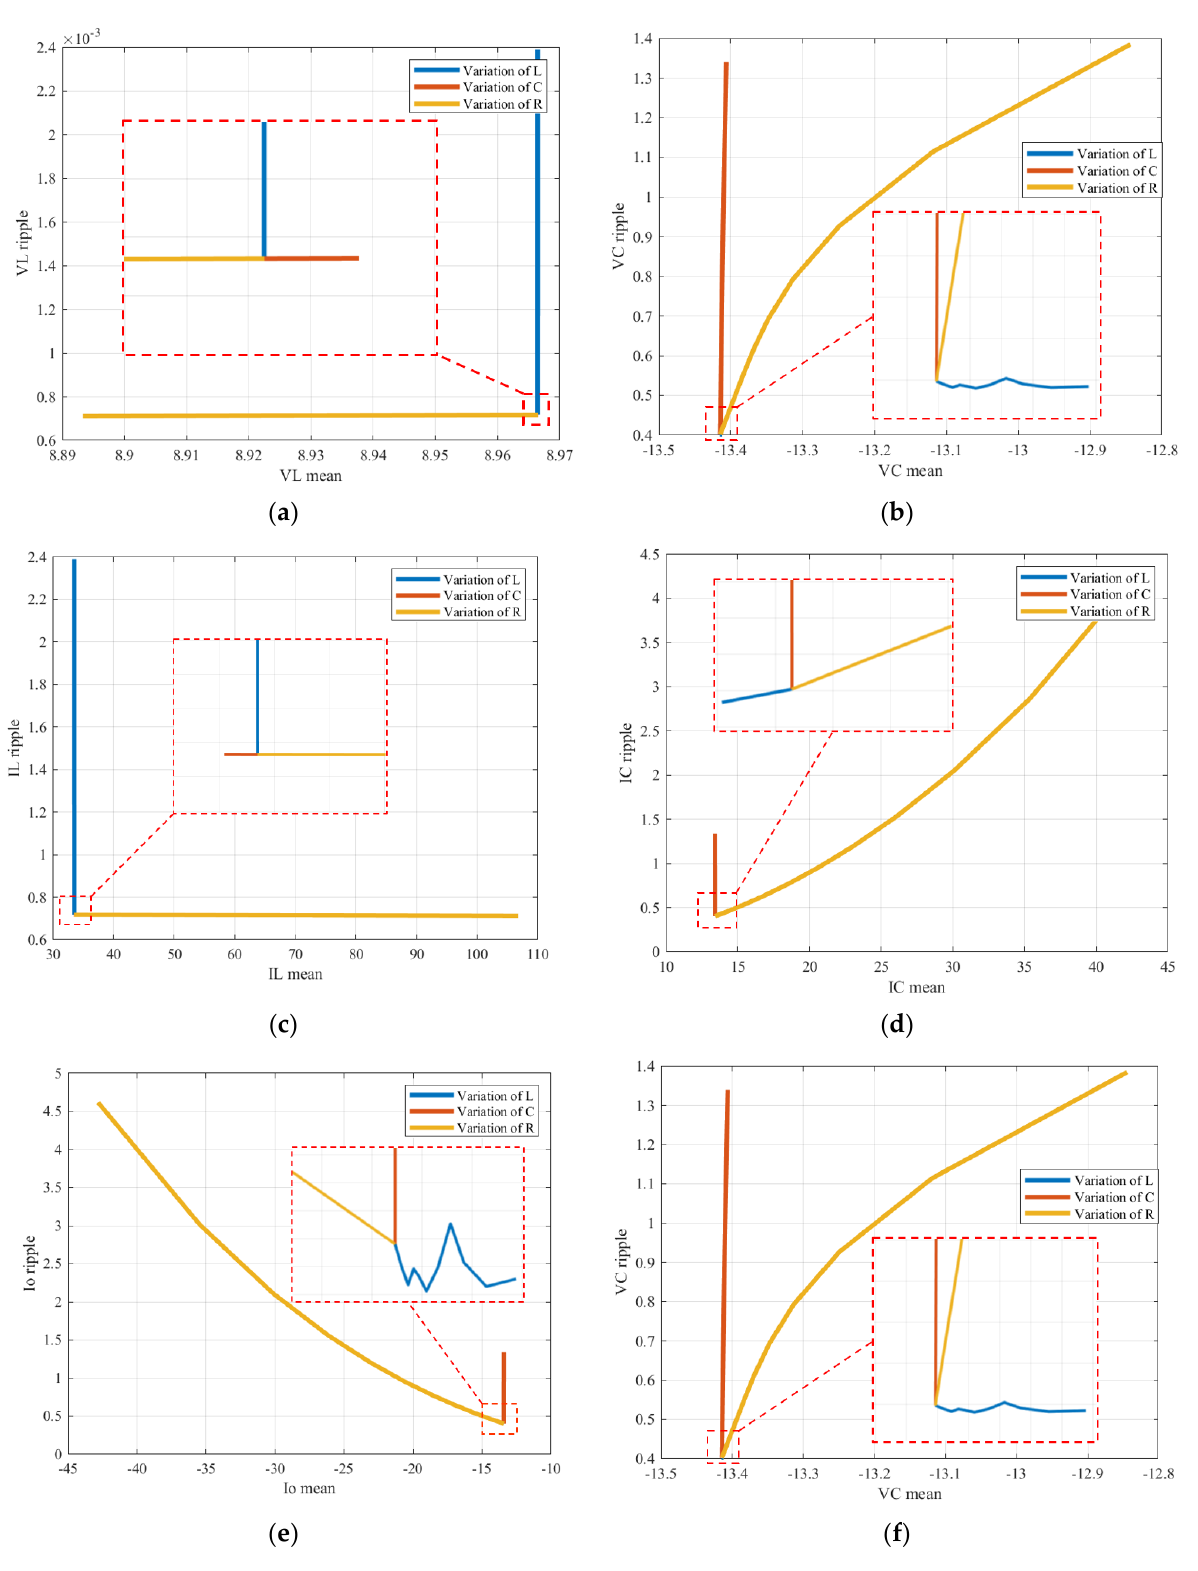
Figure 14. Testability curves for the buck – boost converter in the switch-on period: ( a ) changes in the inductor voltage; ( b ) changes in the capacitor voltage; ( c ) changes in the inductor current; ( d ) changes in the capacitor current; ( e ) changes in the output current; ( f ) changes in the output voltage.